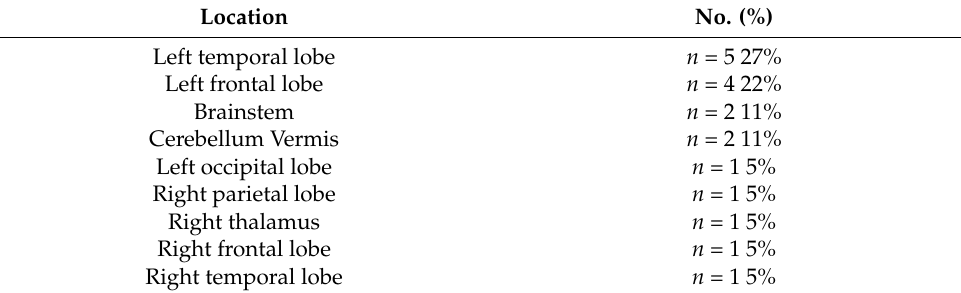
Table 2. Summary of patients’ characteristics.